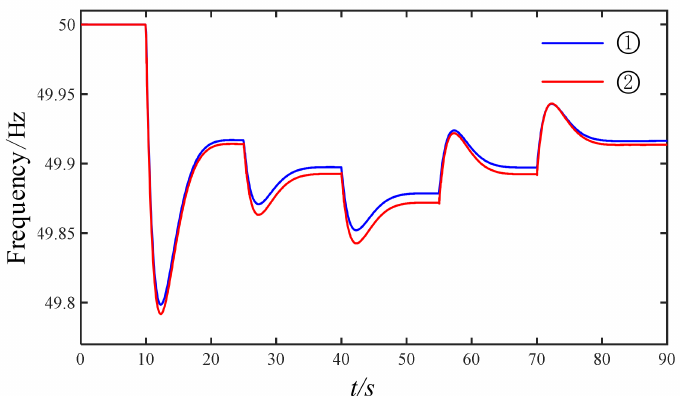
Figure 14. The effect with (blue line 1 (cid:13) )/without (red line 2 (cid:13) ) asynchronous motor on the system frequency characteristics in the process of continuous load put-in and